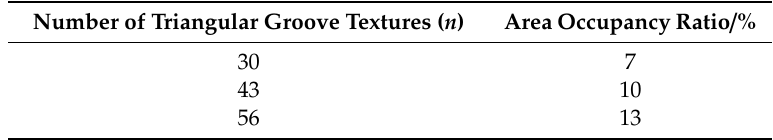
Table 5. Correspondence between the number of triangular groove micro-textures and the area occupancy ratios of texture arrays.